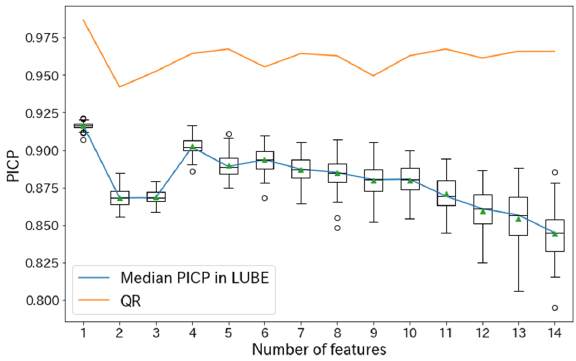
Figure 7. Number of features and 2-week average PICP in LUBE and QR.